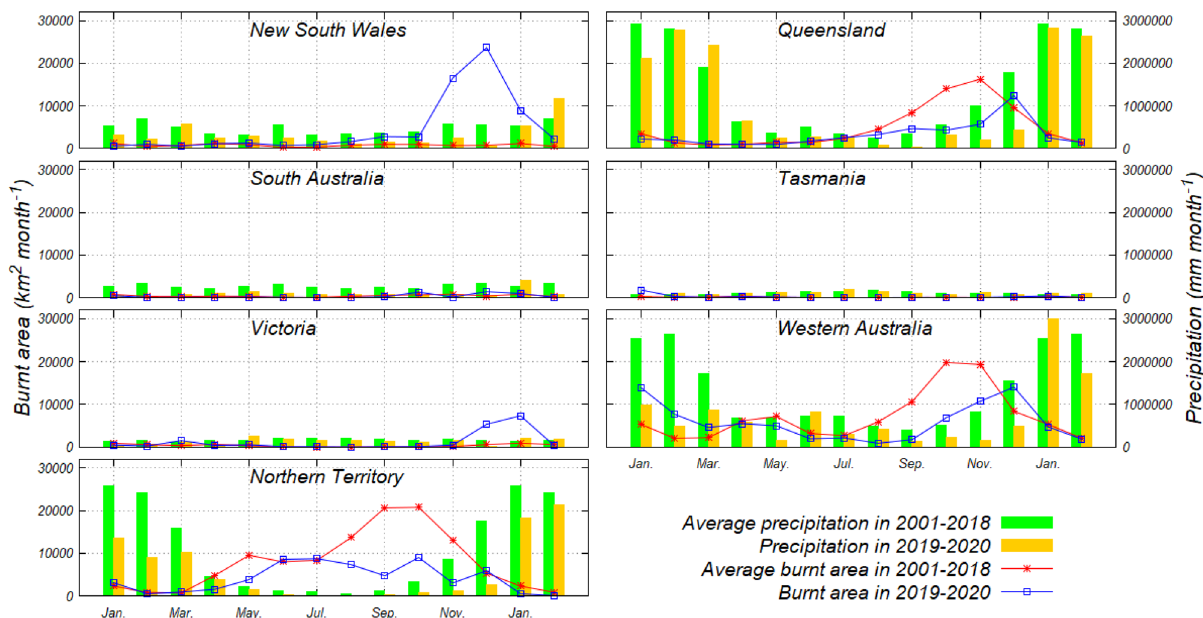
Figure 4. Comparison between monthly precipitation (mm) and monthly burnt area (km 2 ) of LC–M in six states and one territory for 2001–2018, and for 2019–2020, respectively. Note that the horizontal axis shows the period from January to February of the subsequent year to avoid confusion from showing just two months for